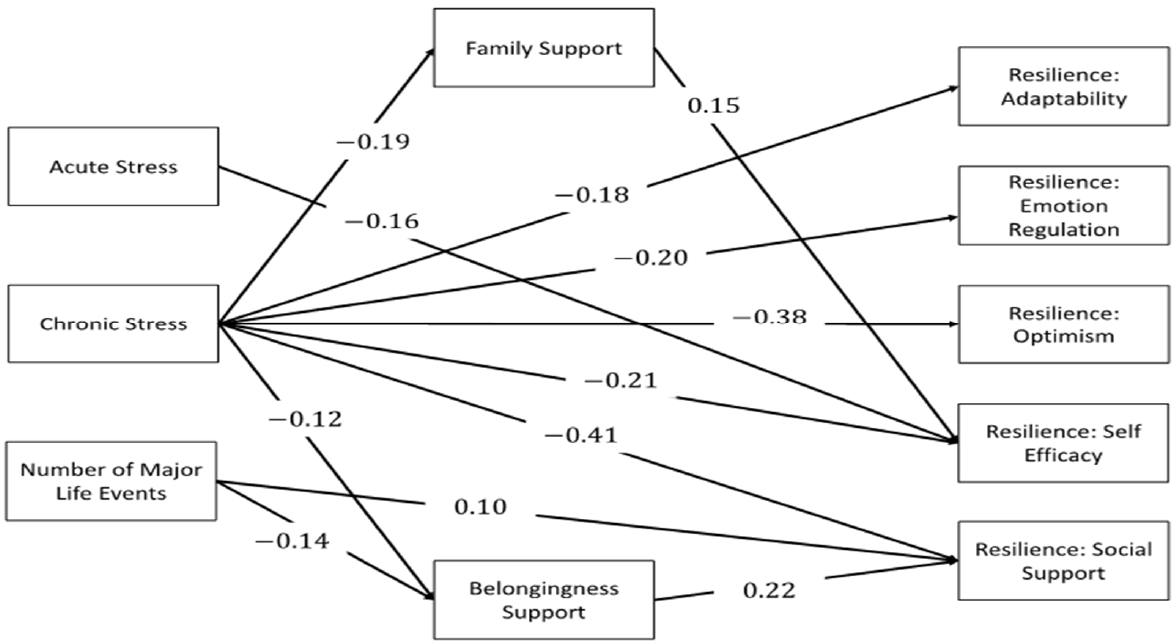
Figure 2. Path analysis model examining family support and belongingness support as mediators of the relationship between chronic stress and resilience and between acute stress and resilience. Correlations and paths with insignificant p -values are not depicted.